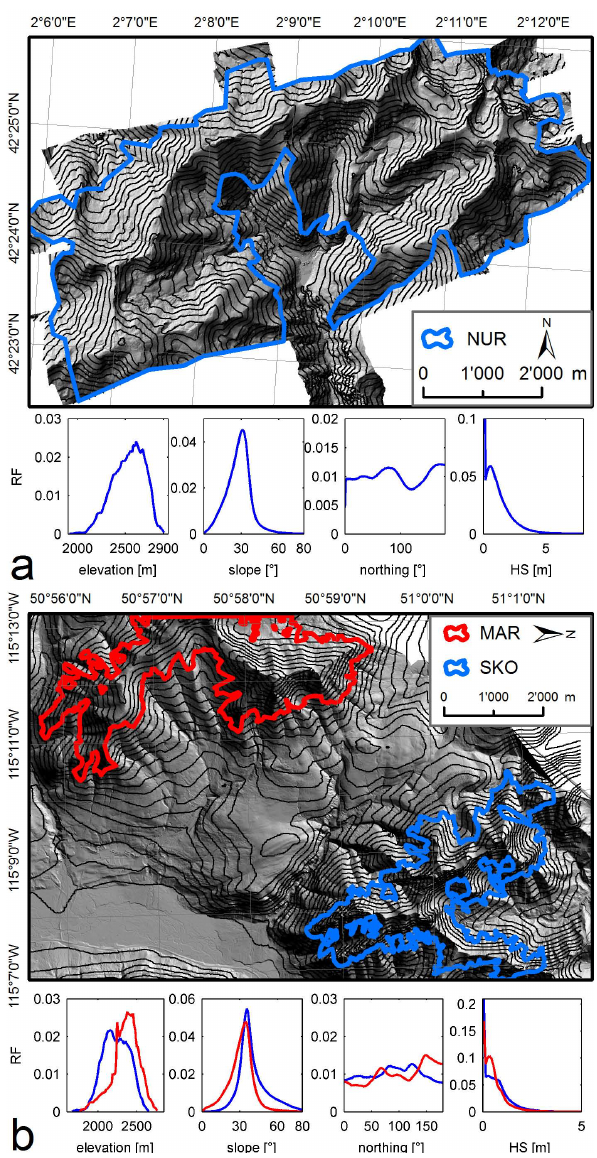
Fig. 3. Hillshade map of (a) the Val de N´uria (NUR) and (b) Mar- mot Creek Research Basin area with the study areas Marmot Creek (MAR) and Skogan Peak (SKO). The contour lines have an equidis- tance of 50m. The panels below show histograms for elevation, slope, northing and the area-wide absolute snow depth obtained from